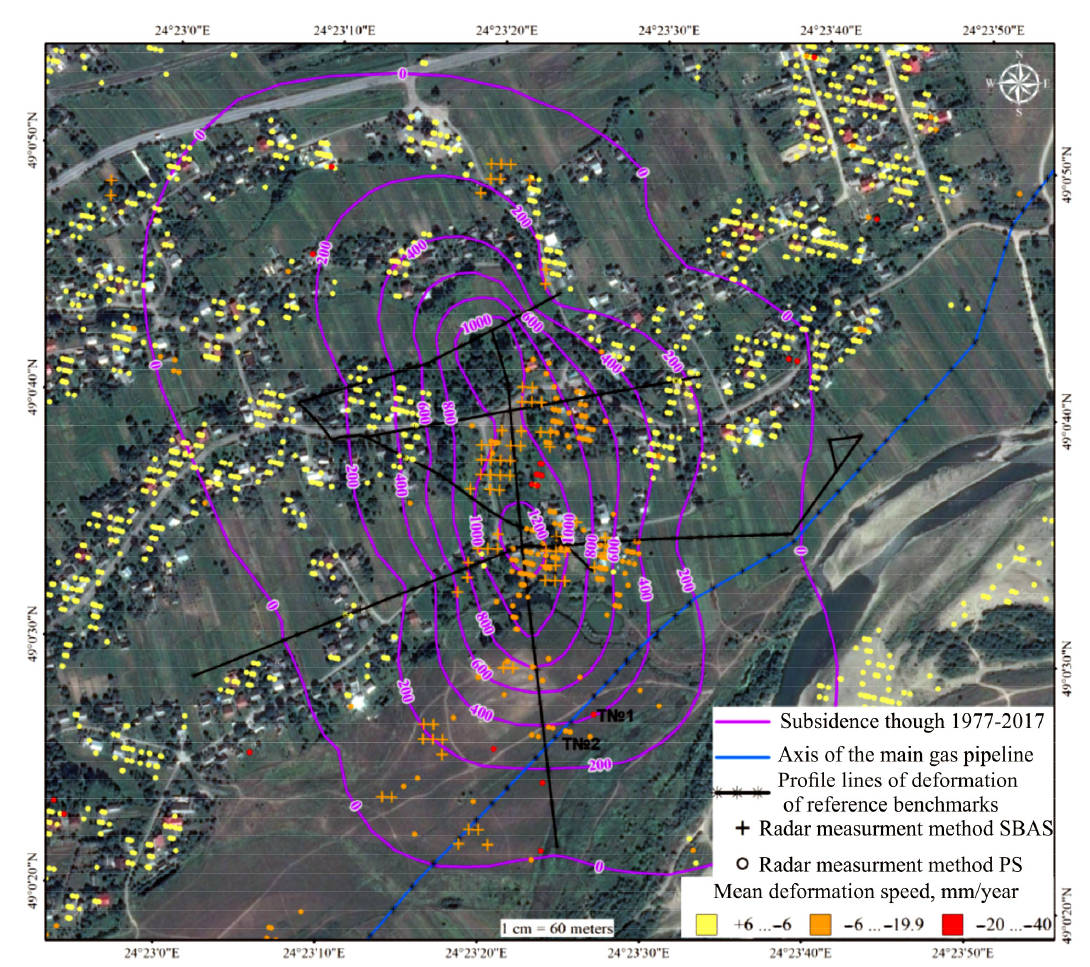
Figure 3. Combined scheme of the results of processes monitoring the displacement of the research area